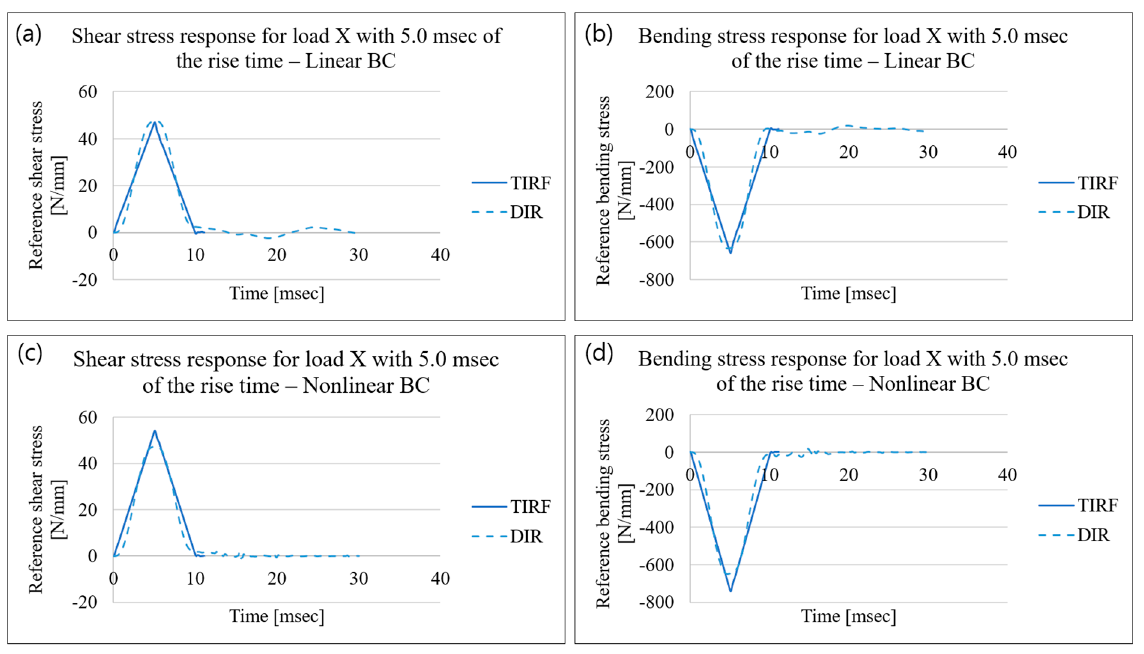
Figure 18. Reference shear and bending responses for Load X (uniform pressure 3 × 3 load case) using TIRF and DIR for impact pressure of 5.0 ms of rise time: ( a ) Reference shear responses with linear boundary conditions, ( b ) Reference bending responses with linear boundary conditions, ( c ) Reference shear responses with nonlinear boundary conditions, and ( d ) Reference bending responses with nonlinear boundary conditions.